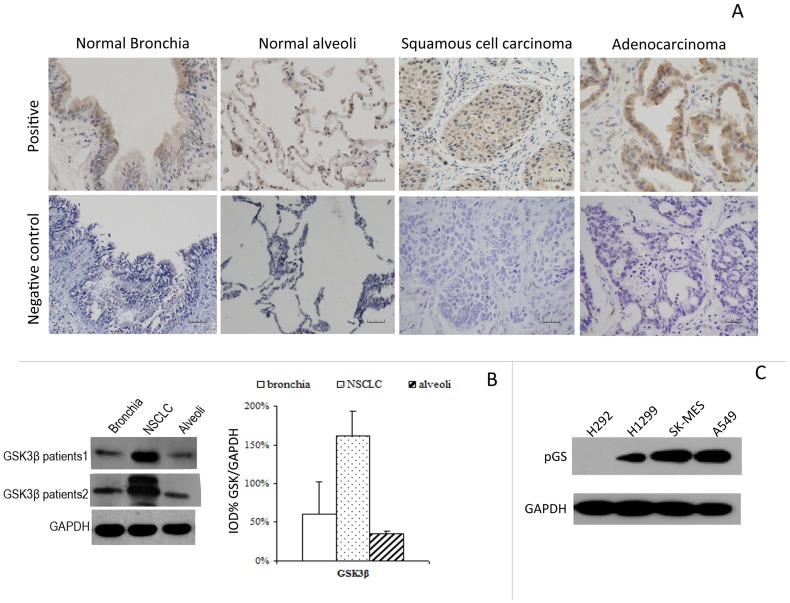
GSK3β is overexpressed and active in NSCLC tumor tissues.(A) Typical IHC staining images of human NSCLC tumor and normal lung tissue (magnification × 200). (B) Western blotting assays confirmed that in paired normal/tumor tissues from NSCLC cancer patients, higher expression levels of GSK3β in tumors were found compared with their normal counterparts. The experiments were repeated 3 times, and the data are presented as the mean ± SD. *P<0.001. (C) Phosphorylated glycogen synthase (pGS), a substrate of GSK3β, was detected in these NSCLC cell lines, except for H292.